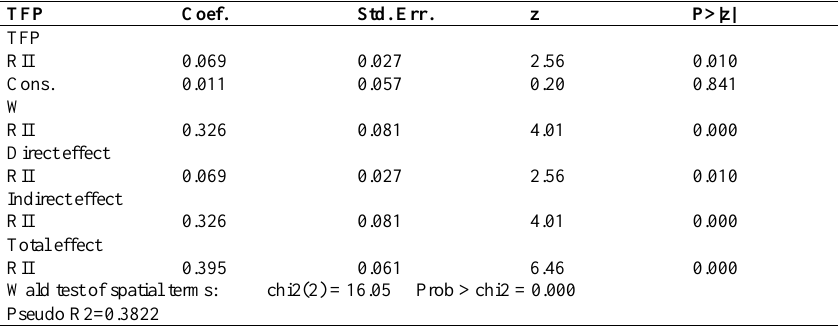
Figure 1. Innovation performance of the EU regions